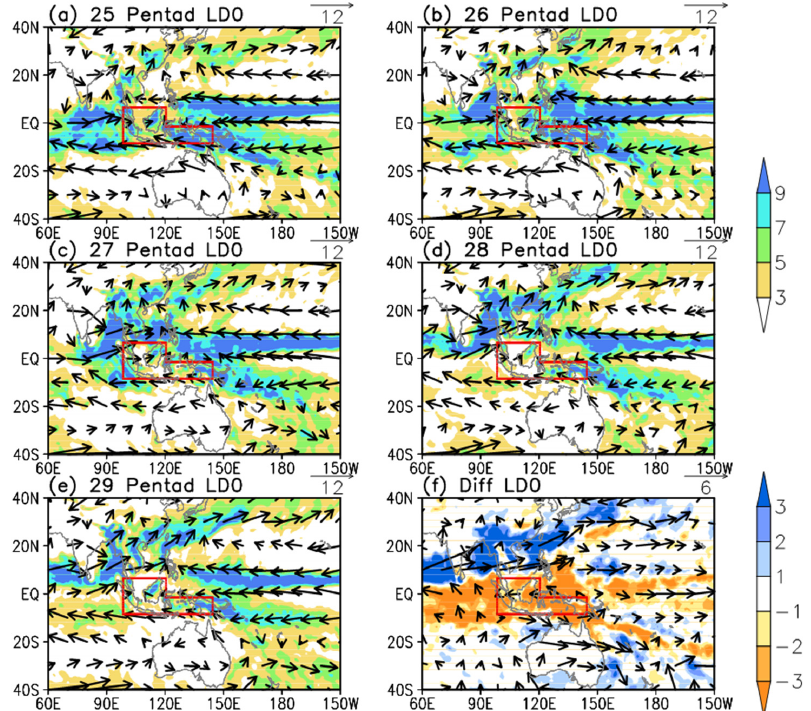
Figure 7. Same as in Figure 3, but for CFSv2 LD0. ( a ) 25th pentad; ( b ) 26th pentad; ( c ) 27th pentad; ( d ) 28th pentad; and ( e ) 29th pentad; ( f ) Differences between 28th–29th pentad mean and 25th–26th pentad mean.